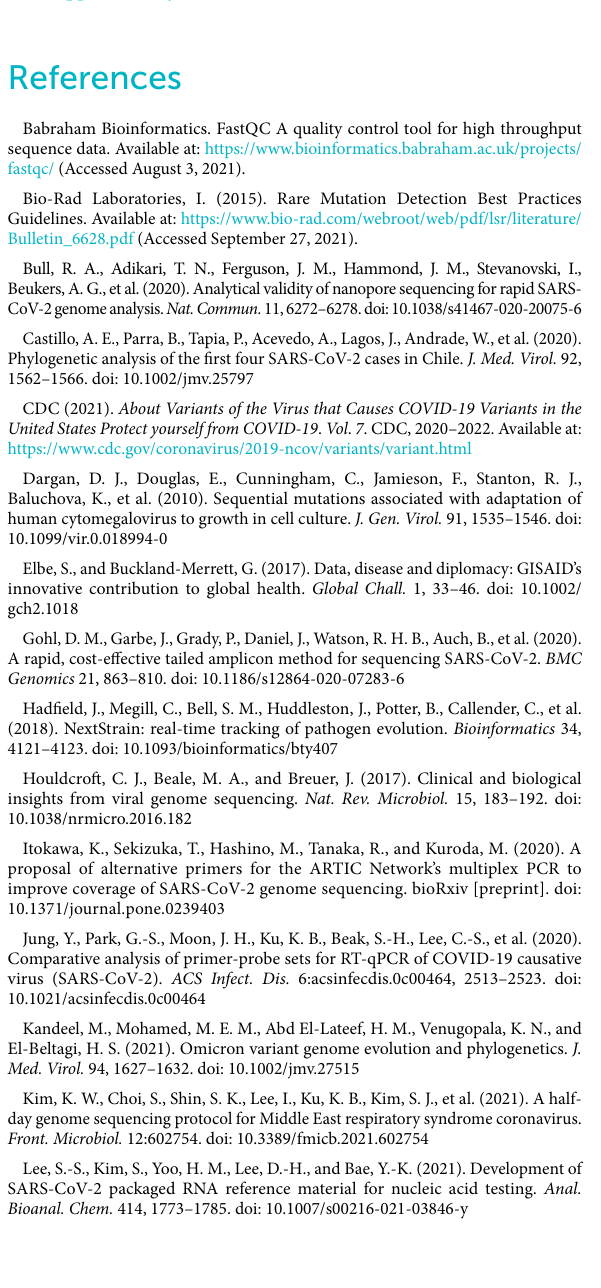
SUPPLEMENTARY FIGURE S1 The RT-qPCR of cultured SARS-CoV-2 variant. The RT-qPCR assay using N gene targeting primer-probe set showed the linearity of standard curves. SUPPLEMENTARY FIGURE S2 Agarose gel electrophoresis of eleven amplicons from SARS-CoV-2 RNA